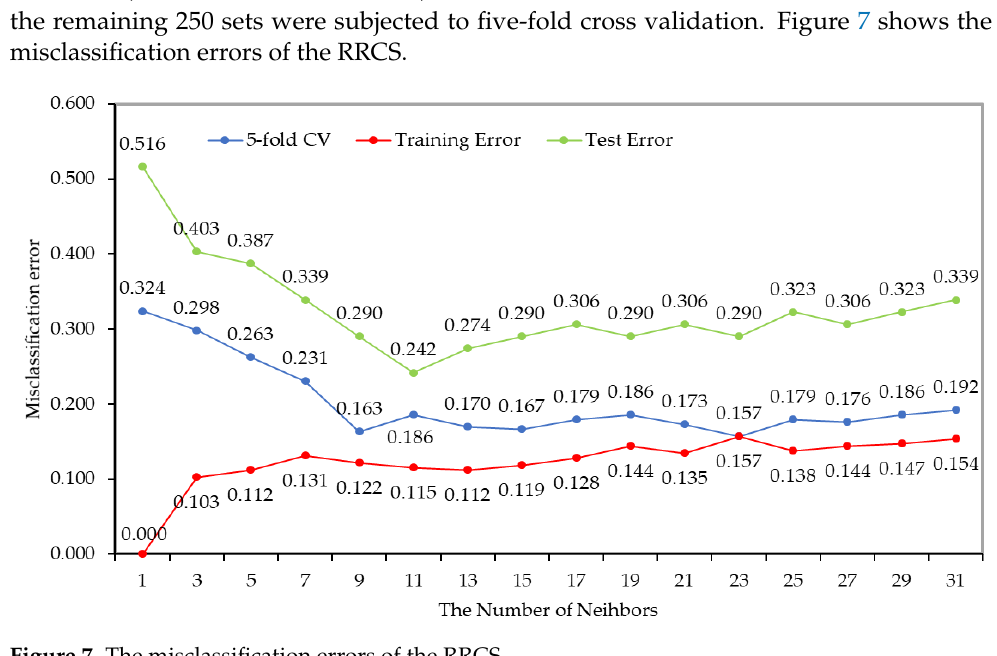
Figure 7. The misclassification errors of the RRCS.